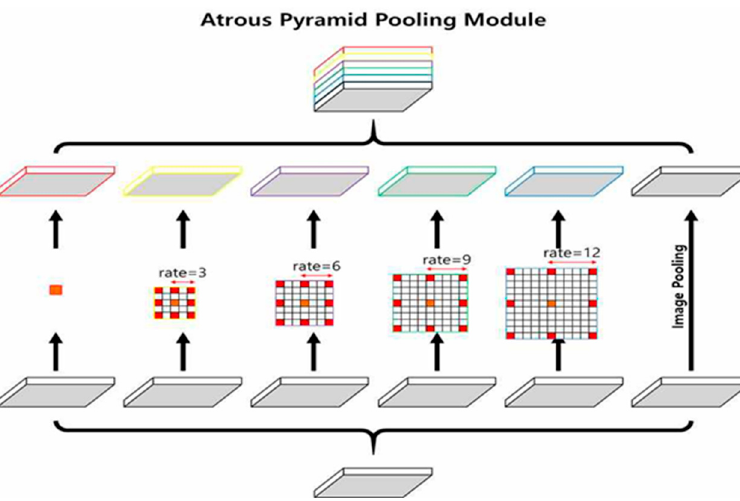
Figure 8. Structure of the atrous pyramid pooling module applied in this study.